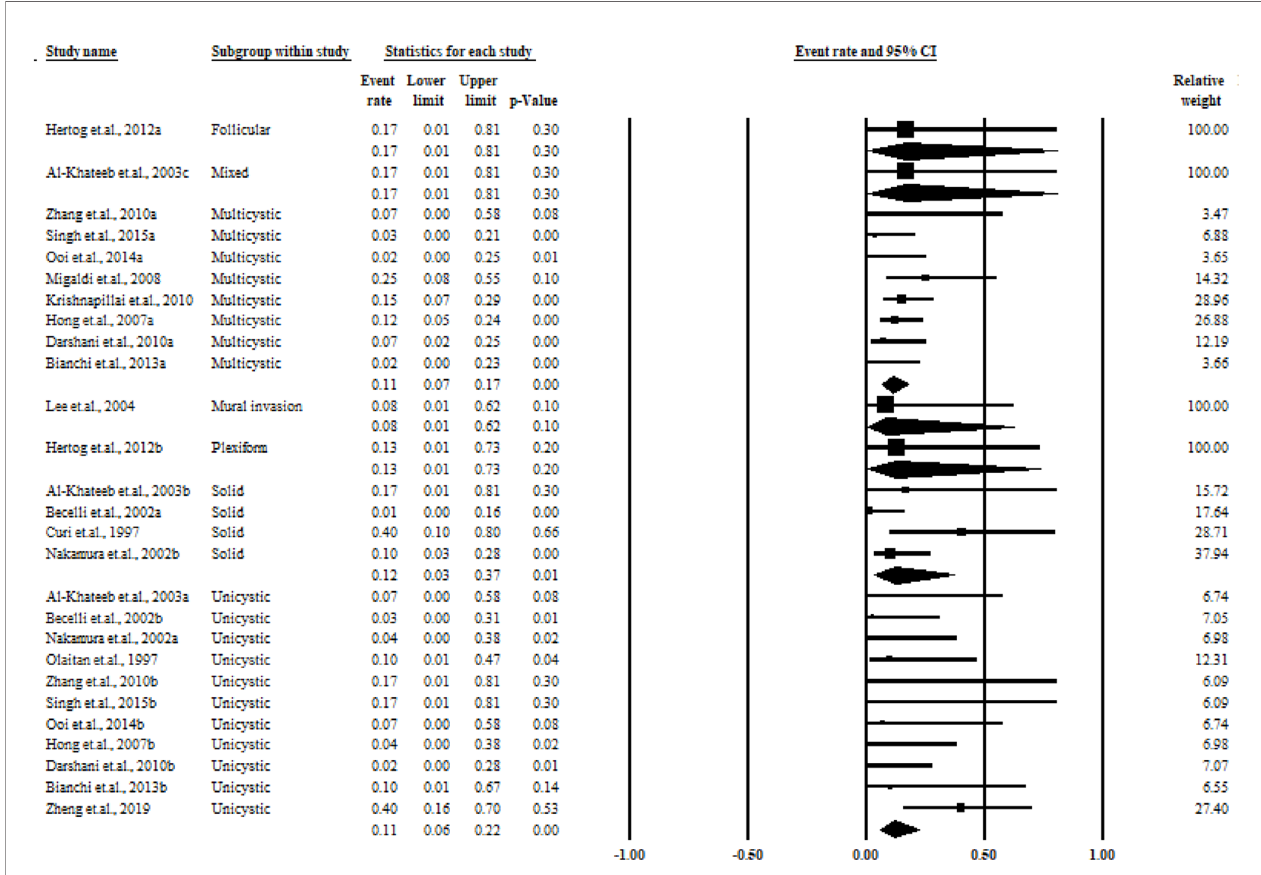
FIGURE 7 | Summary of the aggressive treatment recurrence rate strati fi ed by the histological classi fi